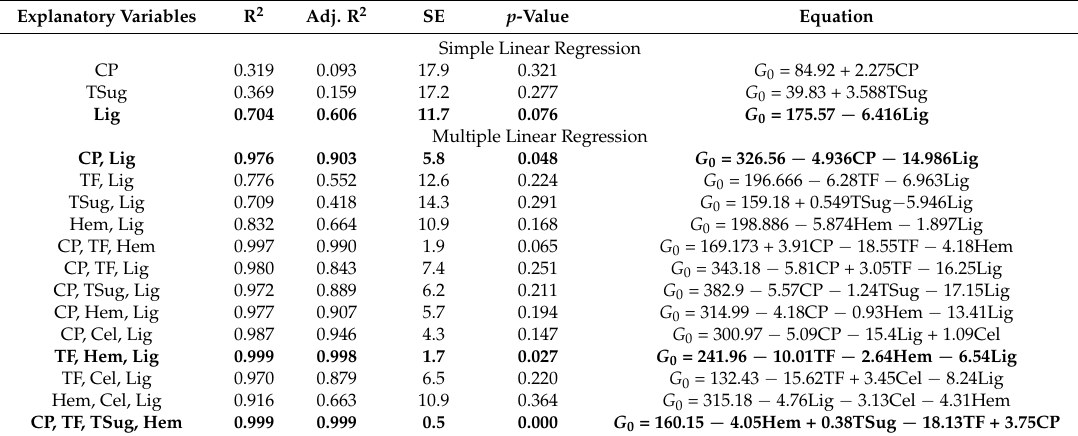
Table 3. Regression of methane potential ( G 0 ) of VCR using explanatory variables. Explanatory